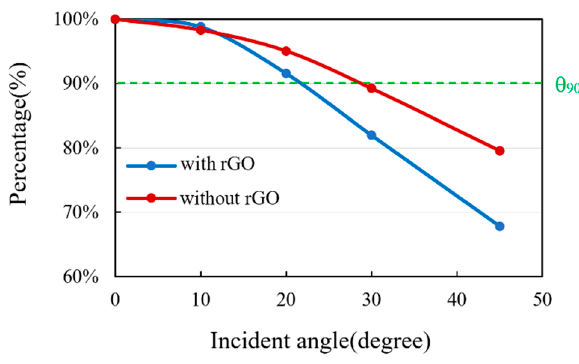
Figure 15. Output signal comparison vs. incident angle.